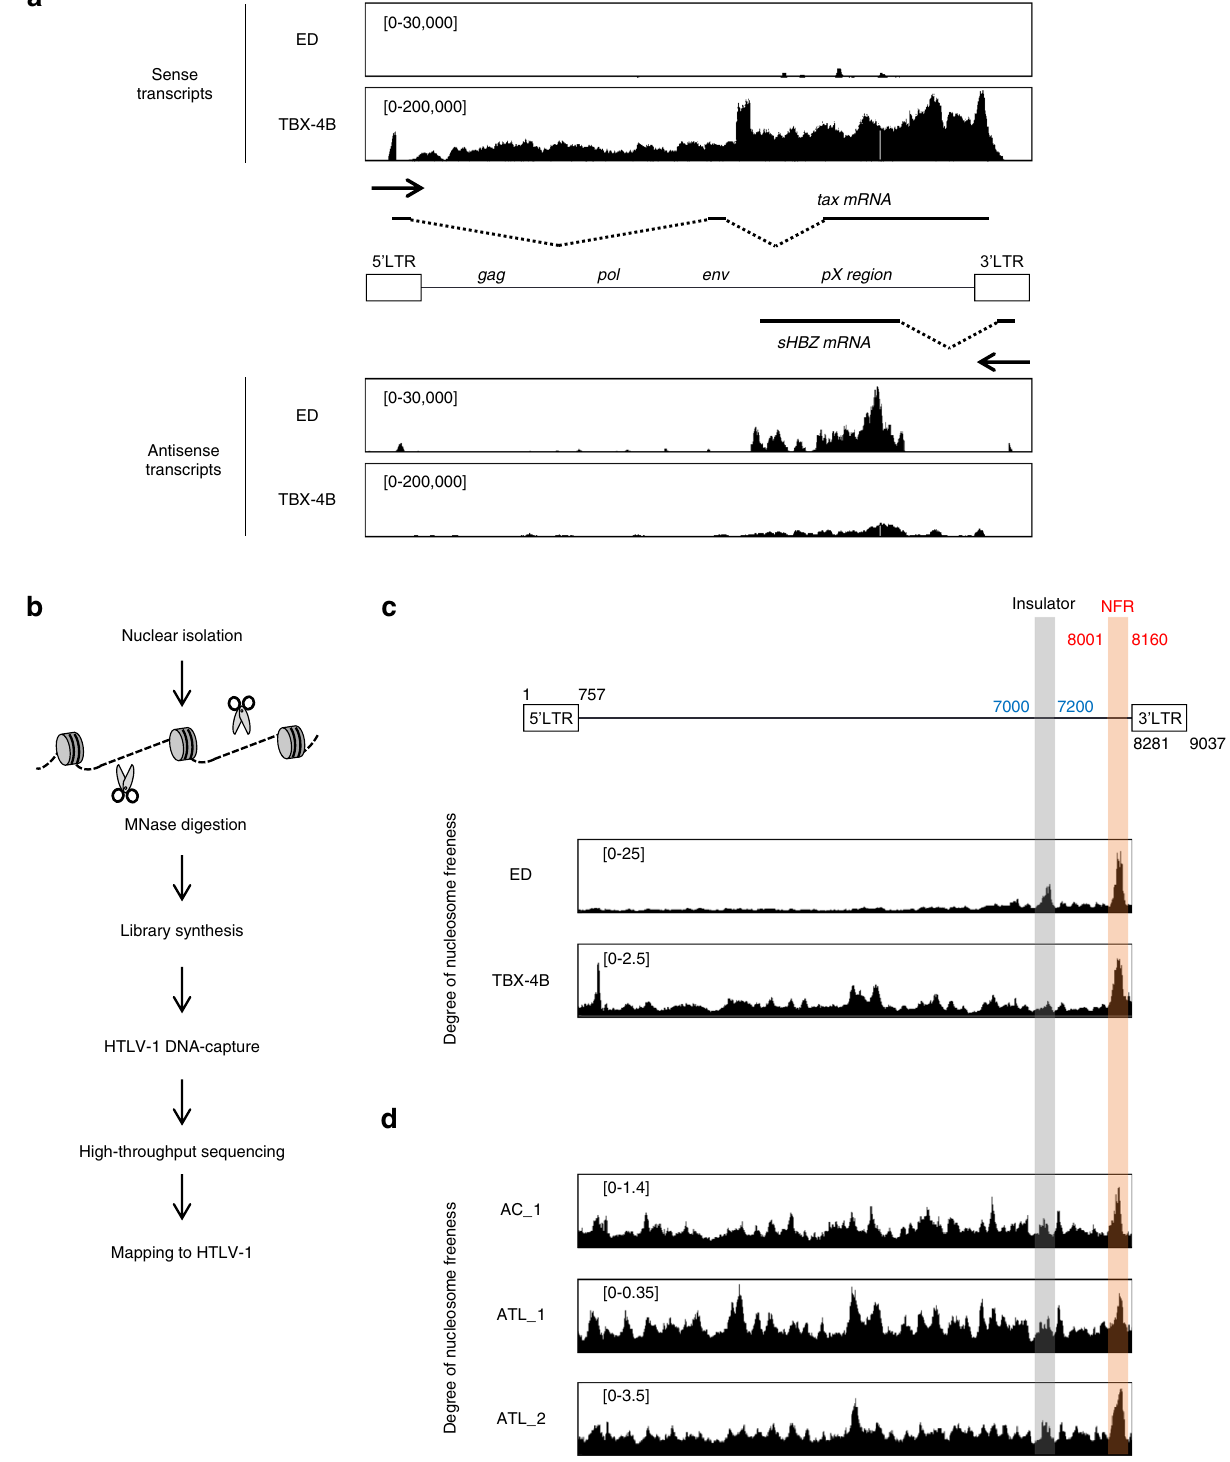
Fig. 1 Transcriptome pattern and nucleosome positions in the HTLV-1 provirus. a Proviral transcriptomes are visualized in the sense (top panel) or antisense (bottom panel) orientation in ED cells and TBX-4B cells by Integrative Genomics Viewer (IGV; https://software.broadinstitute.org/software/igv/). The range in square brackets indicates the range of read counts for each transcriptome. b Experimental work fl ow of MNase-seq with HTLV-1 DNA-capture- seq. c , d MNase-seq of c ED cells and TBX-4B cells and d PBMCs of an asymptomatic carrier (AC) and ATL patients. The range in square brackets indicates the degree of nucleosome freeness which is de fi ned as the MNase-seq value normalized to the input DNA-seq value. Orange-shaded region indicates the NFR location and the gray-shaded region indicates the insulator region. The start and end positions of LTRs, insulator, and NFR are indicated as colored numbers (black, blue, and red,